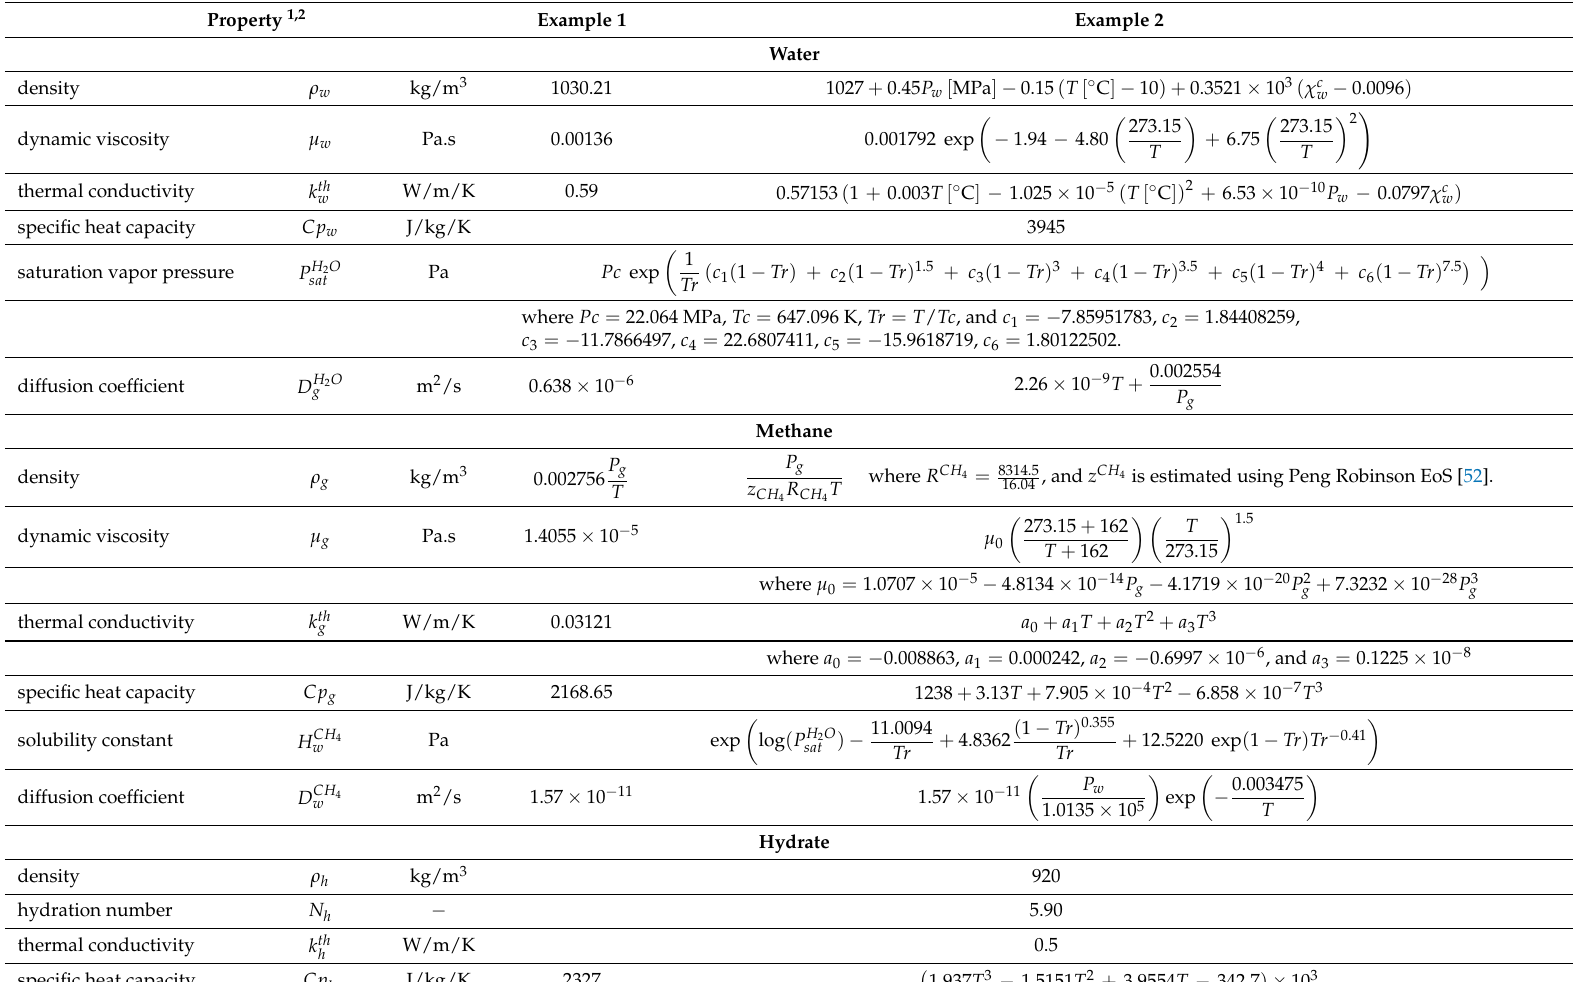
Table 2. Material properties and model parameters for Examples 1 and